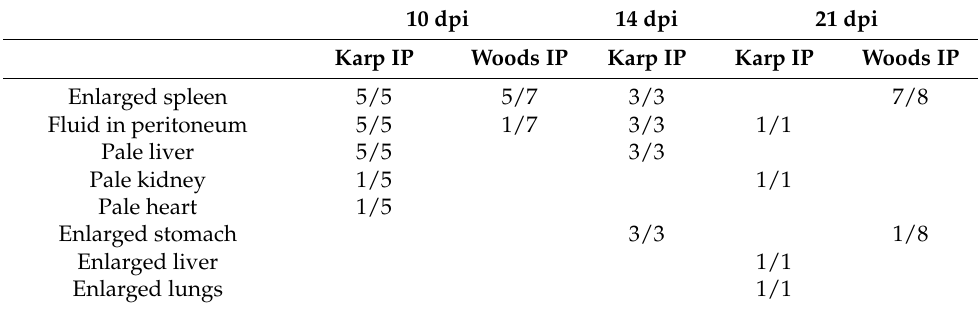
Table 2. Visual observations of affected organs observed in O. tsutsugamushi IP Karp- or Woods- challenged mice (compared to control animals) at the time of necropsy (10, 14, and 21 dpi). The number of mice with affected organs (numerator) out of the total mice in the group (denominator) is indicated for each specific